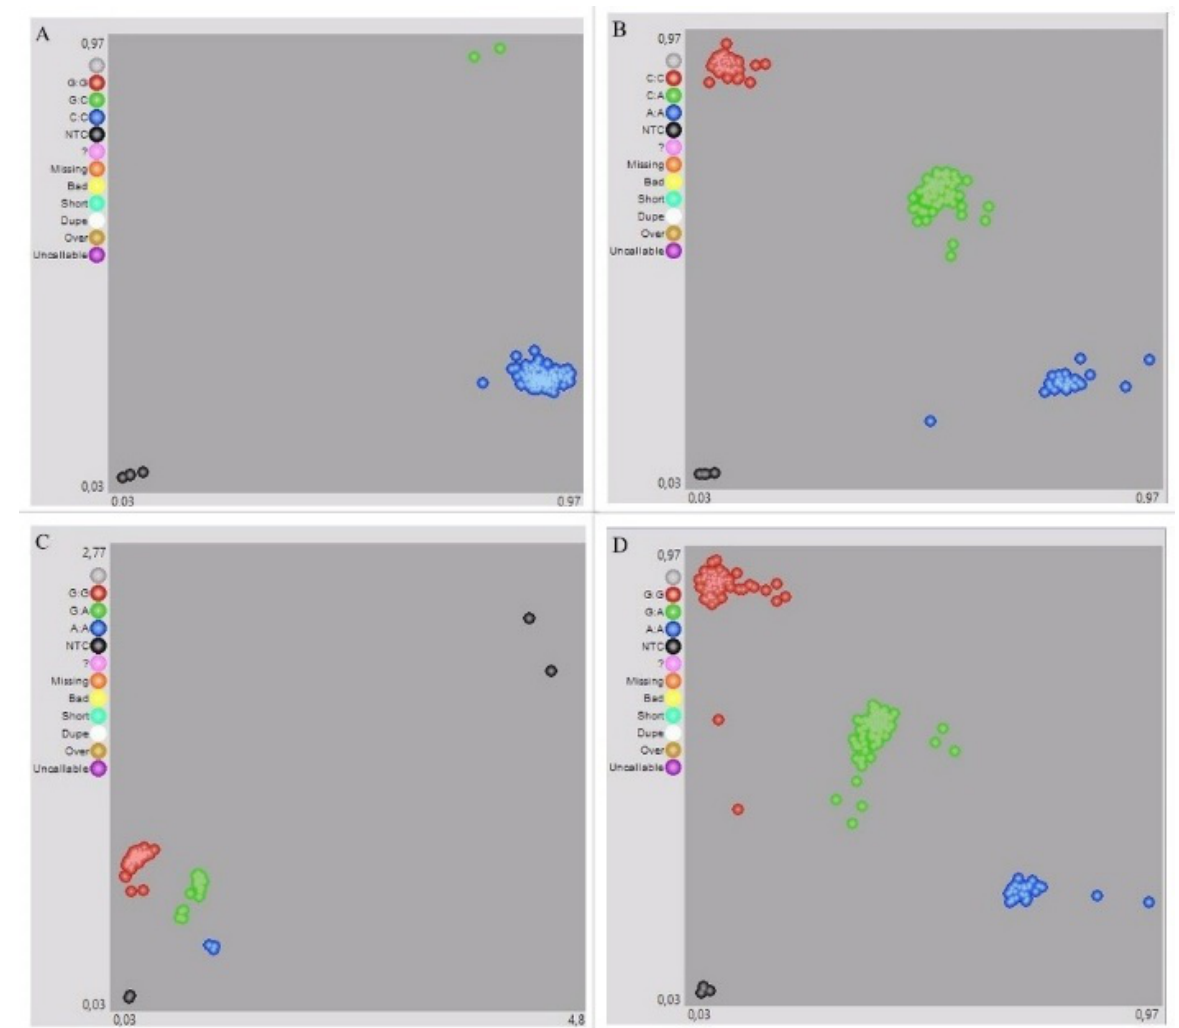
Fig. 1. Representative KASP - Cycle analysis photos for (A) rs6355, (B) rs1800532, (C) rs1386494, (D) rs7305115 SNPs.